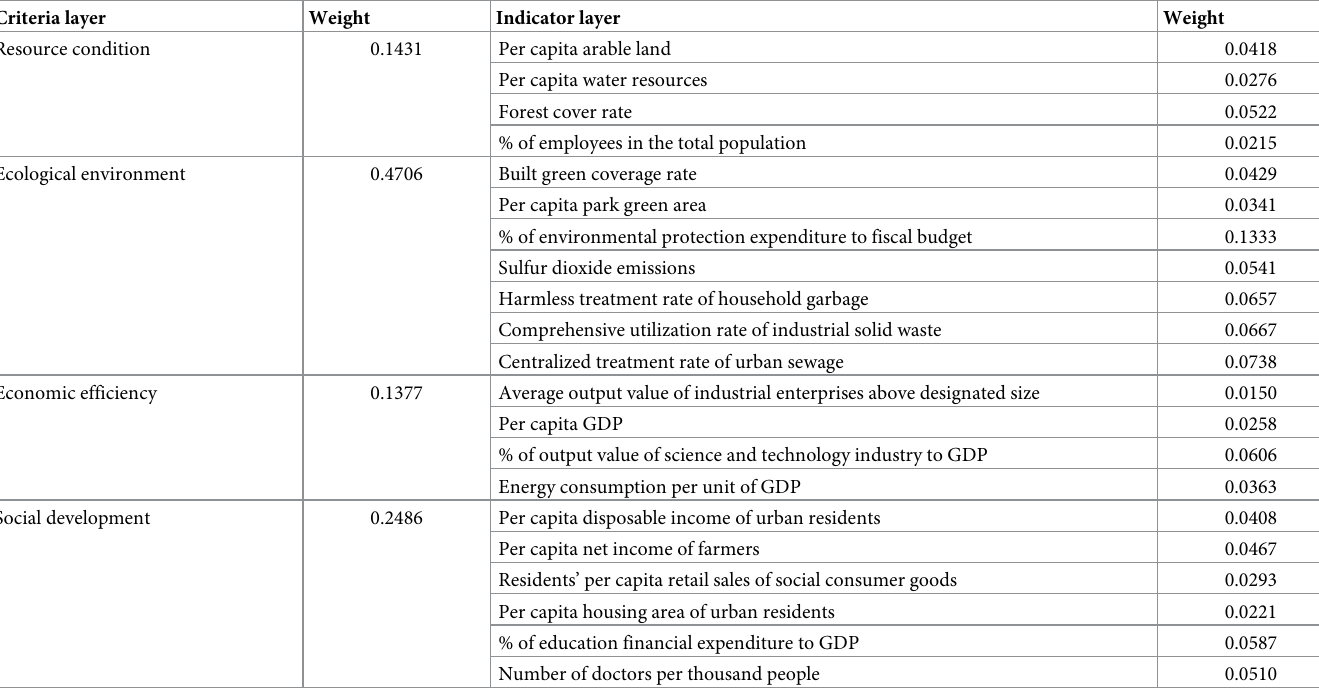
Table 3. Indicator weights of the ecological civilization of Jiangxi